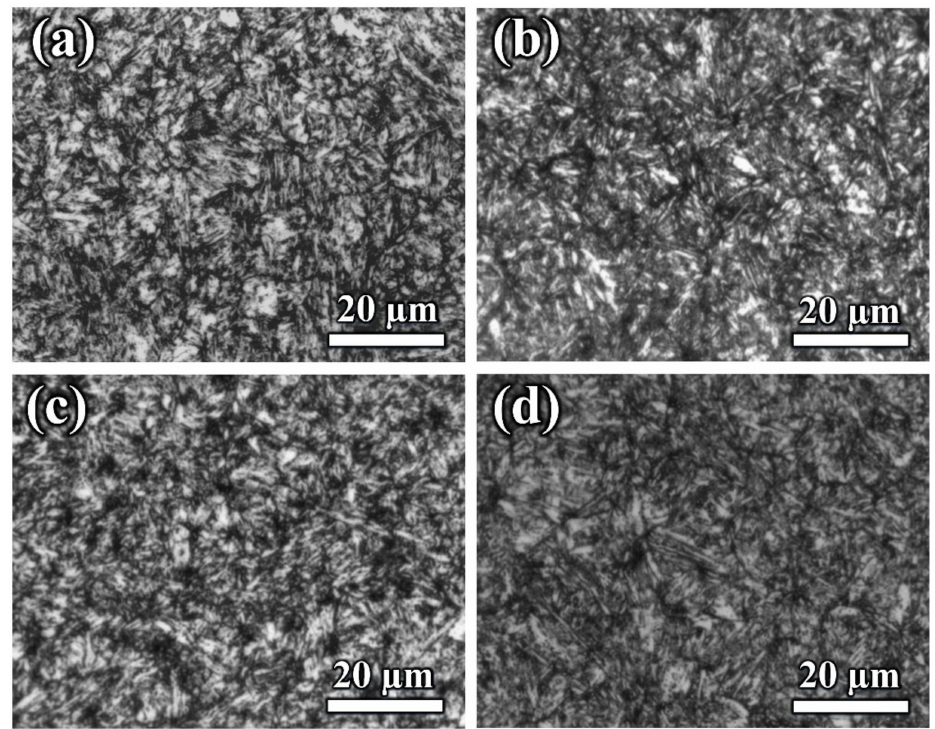
Figure 3. Heat-treated microstructure of H13 steels without and with different types and contents of nanoparticles under optical microscope: ( a ) H13; ( b ) 0.02 wt.% TiC; ( c ) 0.01 wt.% TiC+ TiB 2 ; ( d ) 0.02 wt.% TiC + TiB 2